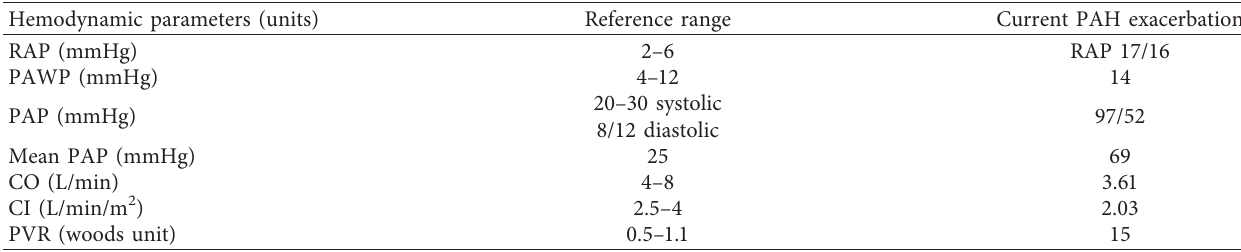
Table 1: Hemodynamic parameters from right heart catheterization.